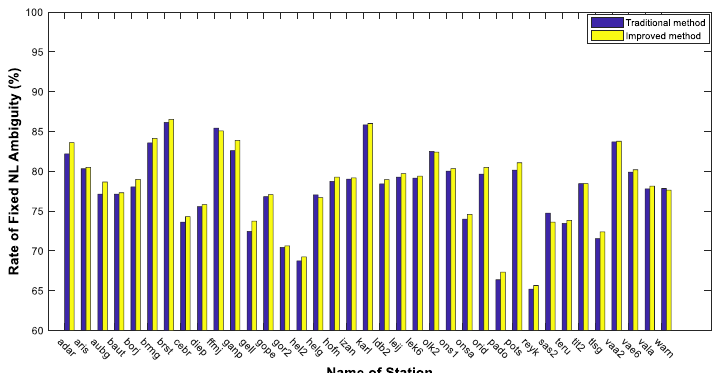
Figure 11. Rate of fixed NL ambiguities by using different bias products (2021, day 185).